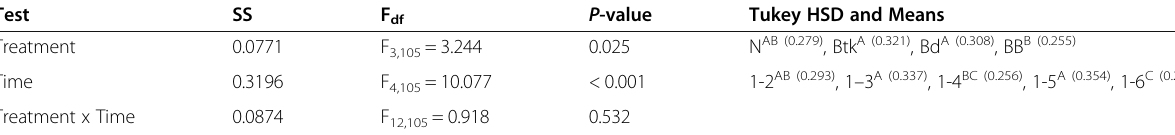
Table 3 Results of pairwise ANOVA tests of Axis Weighted Ordination Distance (AWOrD) values across treatment (N, Btk, Bd, BB), time contrasts (T1 vs. T2, T1 vs. T3, T1 vs. T4, T1 vs. T5, T1 vs. T6) and their interactions for the same individual frog. Presented are sum of squares, F-statistics, P-value, and presented in superscripts are the results of post-hoc Tukey HSD (connecting letters) and AWOrD means for each